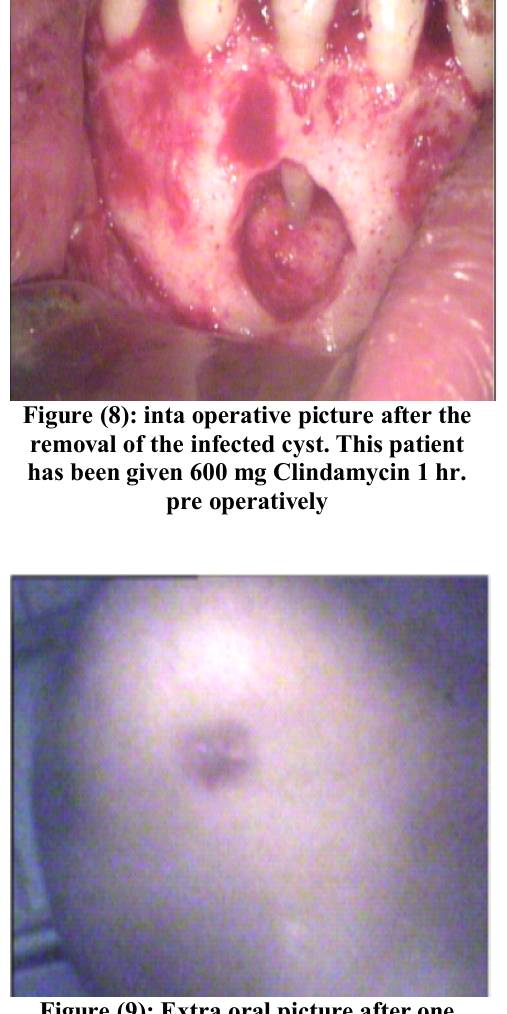
Figure (9): Extra oral picture after one month of the operation shows the process of healing of the extra oral